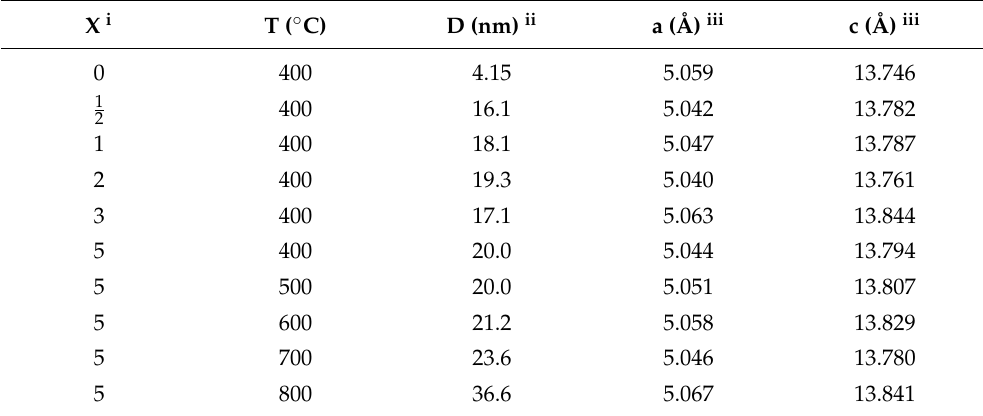
Table 1. Crystallite size ( D ) and lattice parameters ( a and b ) for variable potassium loading ( x ) and calcination temperature ( T